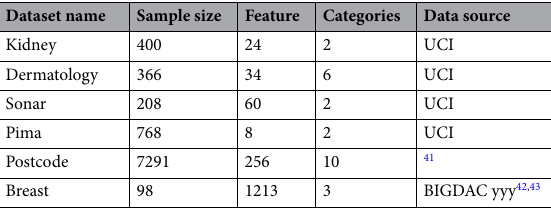
Table 1. Data information. UCI: http:// archi ve. ics. uci. edu/ ml/ index. php. BIGDAC: http:// porta ls. broad insti tute. org/ cgi- bin/ cancer/ datas ets.